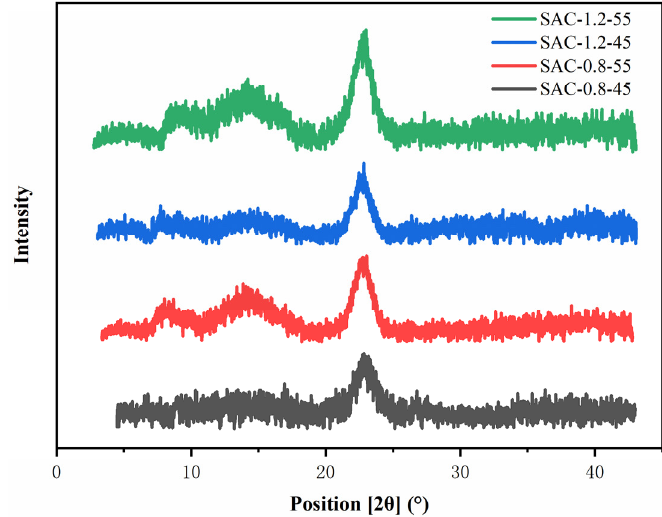
the same time, the transition from orientation to crystal order requires lower energy and is more conducive to the improvement of crystallinity [21]. Figure 4. ( a ) The dynamic hydrogen bonds of SA/AKP/CNCs composite fiber, ( b ) different types of hydrogen bonds, ( c ) Fracture and recombination of hydrogen bonds.